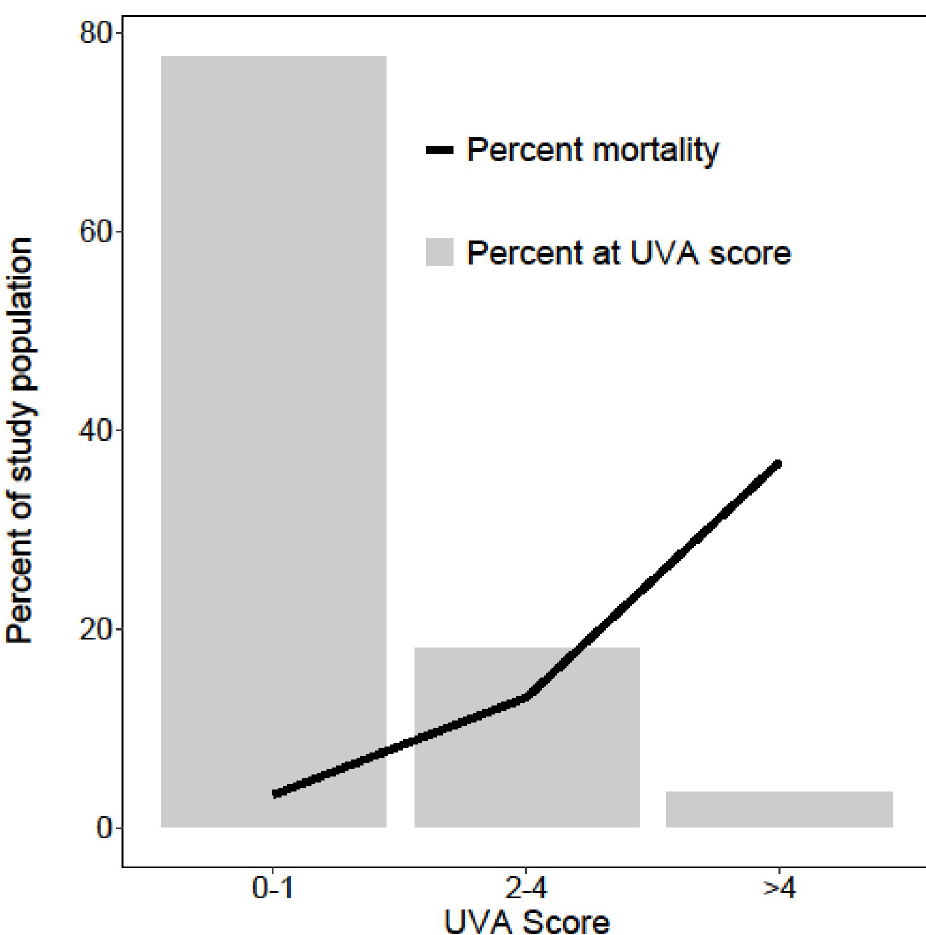
Fig 3. The frequency and associated case fatality rate of UVA score risk categories (low 0–1, medium 2–4, high > 4) of adult patients admitted to hospital with acute infection in Gitwe, Rwanda.